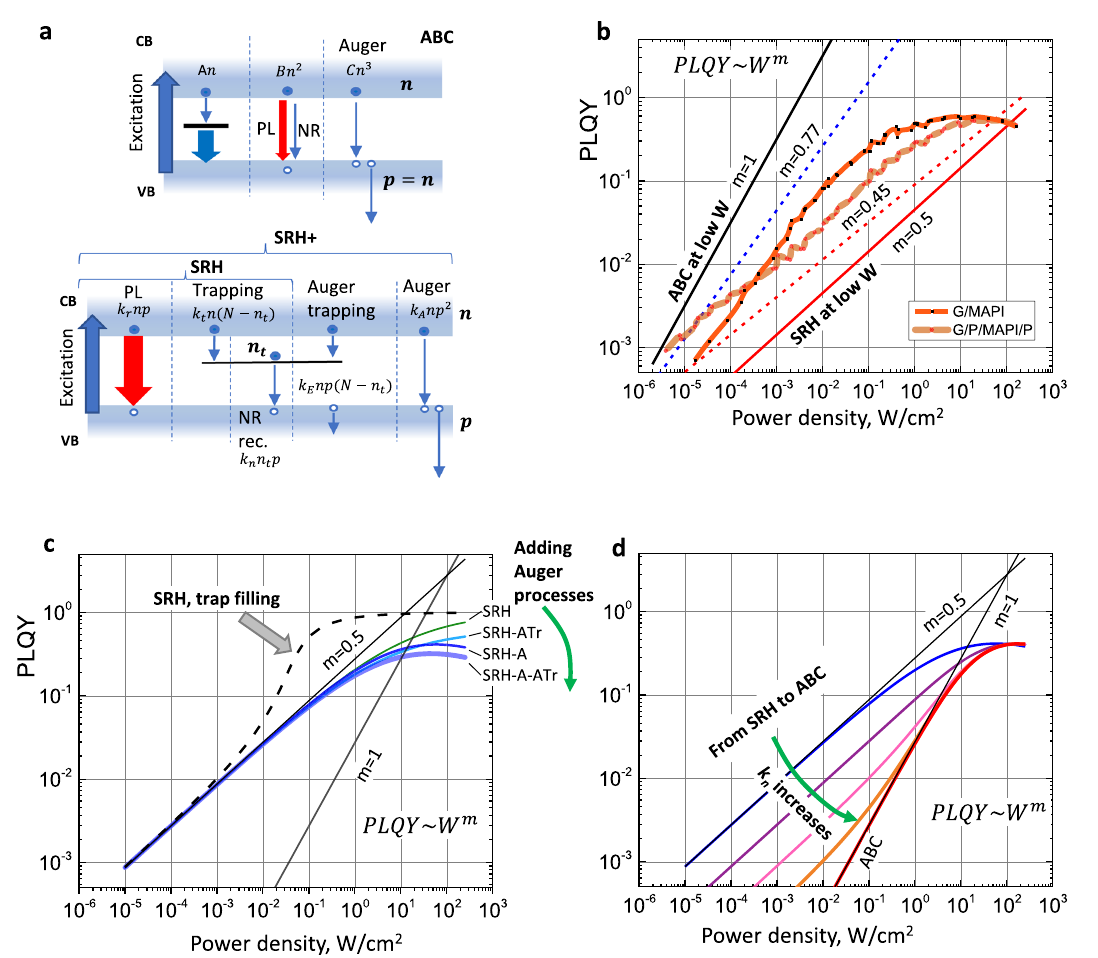
Fig. 4 CW regimes of the ABC, SRH and SRH + models and their comparison with the experiment. a The energy level scheme, the processes and parameters of all models (see the text and Supplementary Note 9 for details). b The experimental dependence (G/MAPI and G/P/MAPI/P samples) of PLQY on the excitation power density W in the quasi-CW excitation regime, m is the exponent in the dependence W m . c PLQY(W) in the CW regime for different models and trap feeling conditions. “ -A ”— adding Auger recombination, “ -ATr ”— adding Auger trapping (Supplementary Note 11). d Evolution of the PLQY( W ) upon the transformation of the SRH model with Auger recombination to the ABC model with increasing of the parameter k n (see Supplementary Note 11 for the model